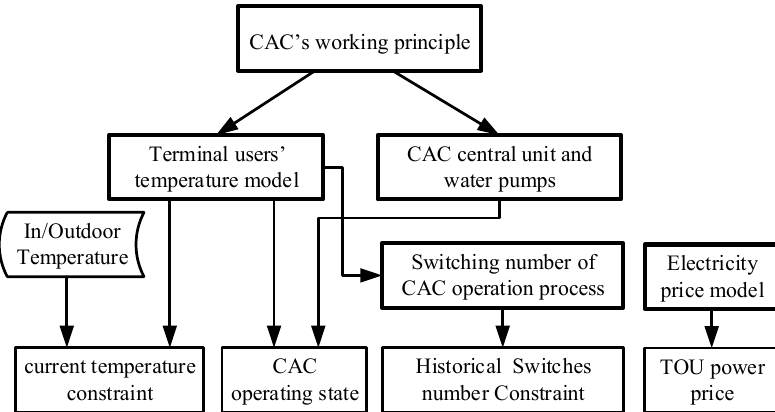
Figure 2. The Relation between Detailed Models of Central Air-conditioner (CAC).